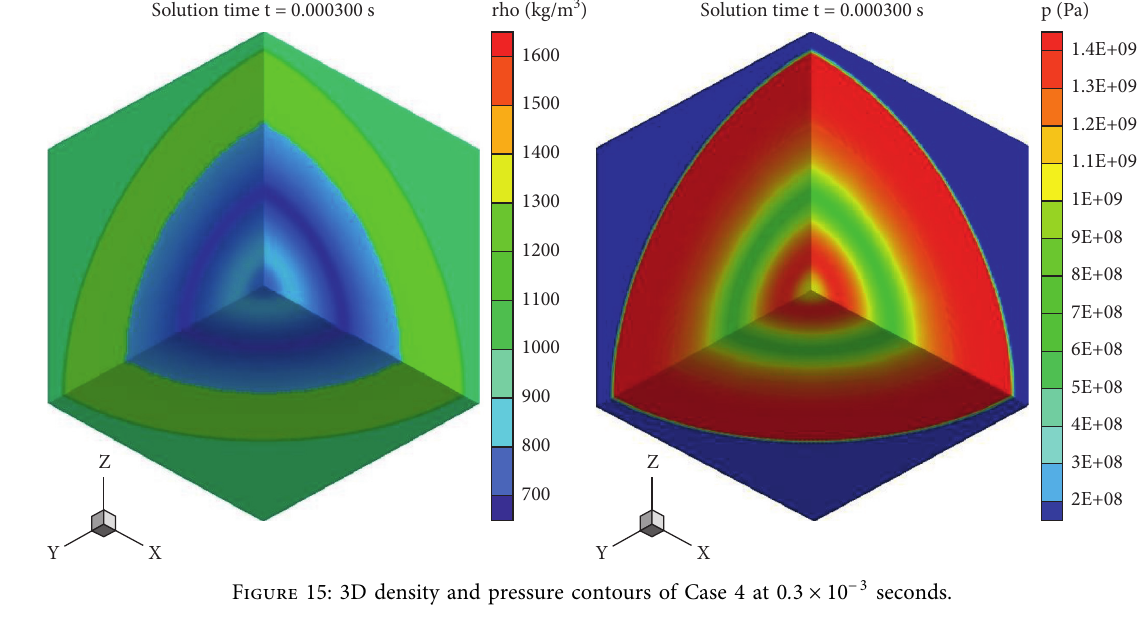
Figure 15: 3D density and pressure contours of Case 4 at 0 . 3 × 10 − 3 seconds.